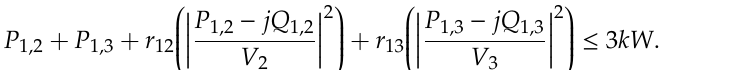
Figure 3. Contribution of inverter 1 to load 2 along with the electricity price.